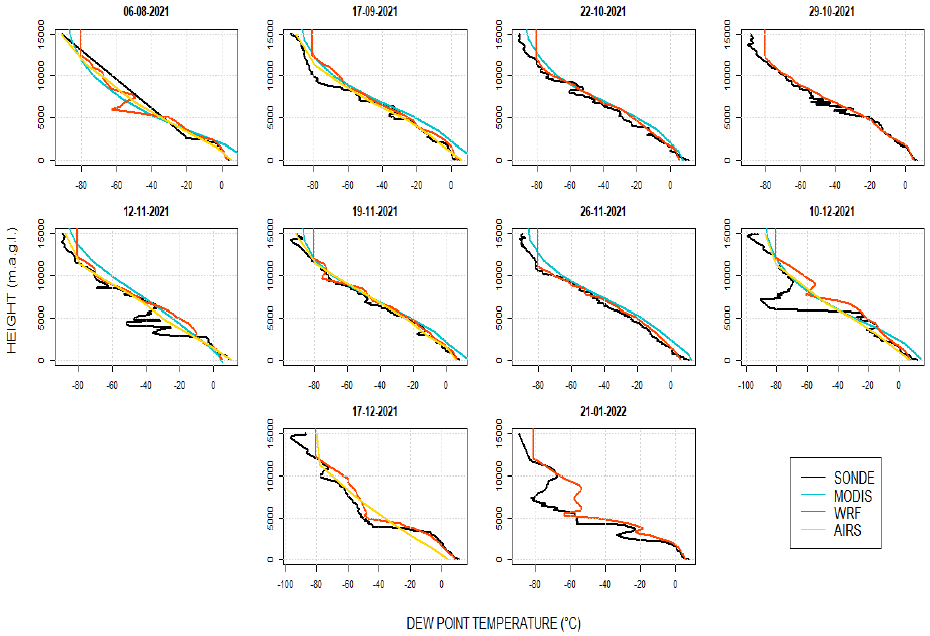
Figure 7. Dewpoint temperature profiles measured with radiosonde (black), MODIS (sky-blue), AIRS (yellow), and WRF (orange) up to 15,000 magl. for 10 measurement events.